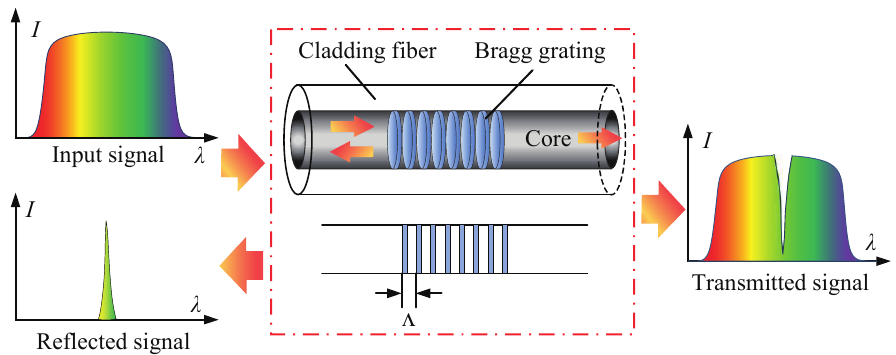
Figure 1. Transmission and reflection spectrum of fiber Bragg grating